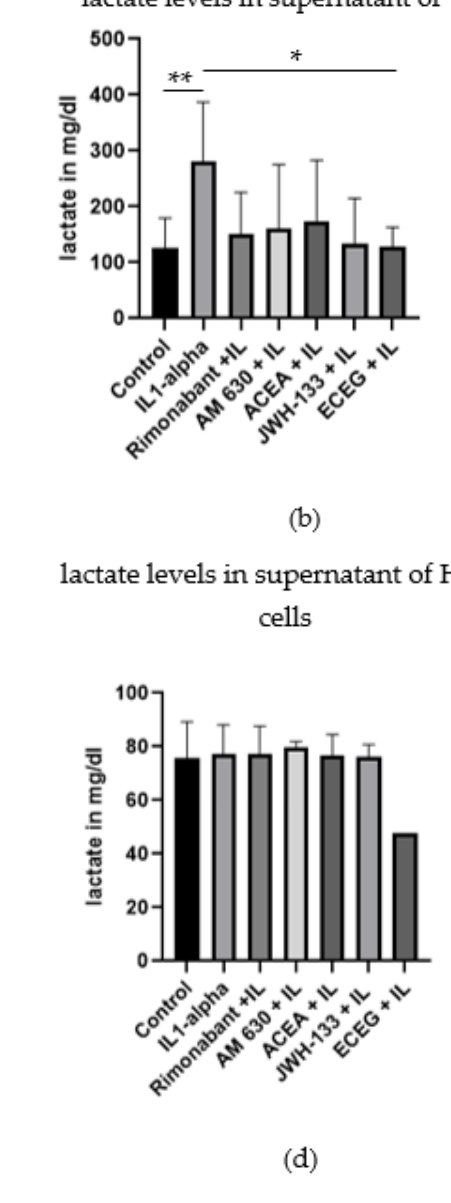
Figure 6. Concentration of glucose ( a ) and lactate ( b ) in the supernatant of VSMC after 48 h of treatment with compounds and IL-1 α stimulation. Concentration of glucose ( c ) and lactate ( d ) in the supernatant of H9c2 cells after 48 h of treatment with compounds and IL-1 α stimulation. The values are expressed as mean ± SD (VSMC, n = 3–9; H9C2 cells, n = 3). Statistical testing was performed using unpaired t-tests. (* p < 0.05; ** p < 0.01).